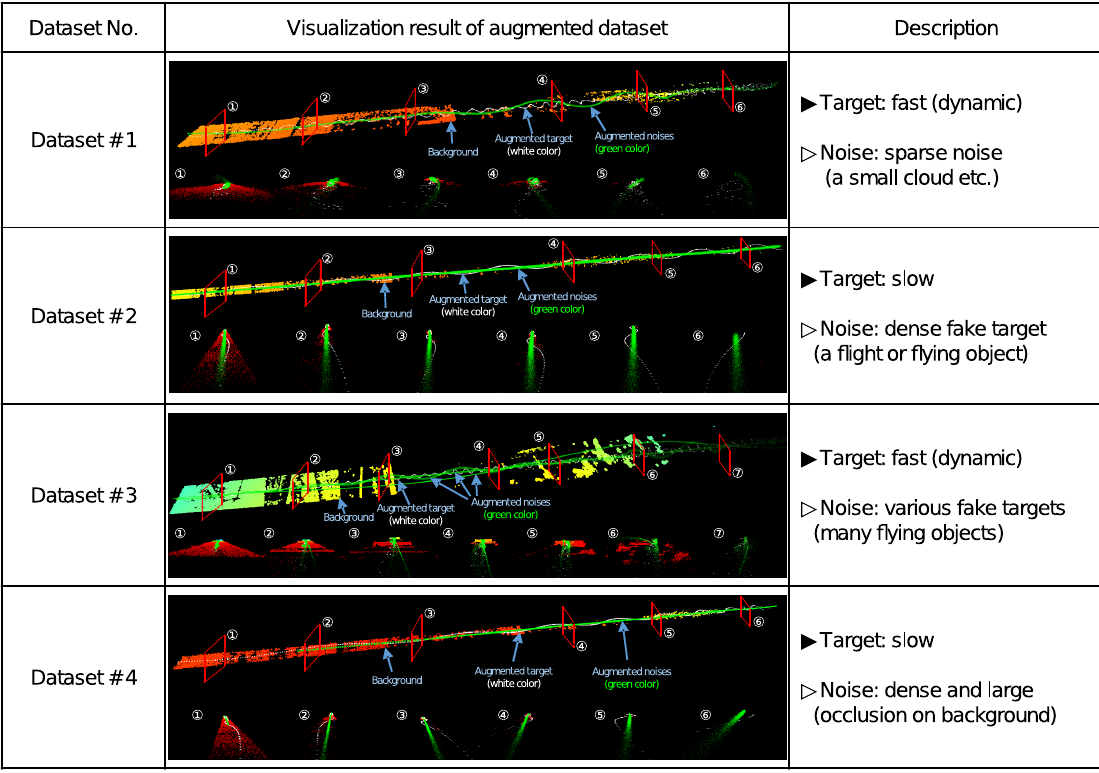
Figure 8. Numbers of visualization result of augmented datasets and its